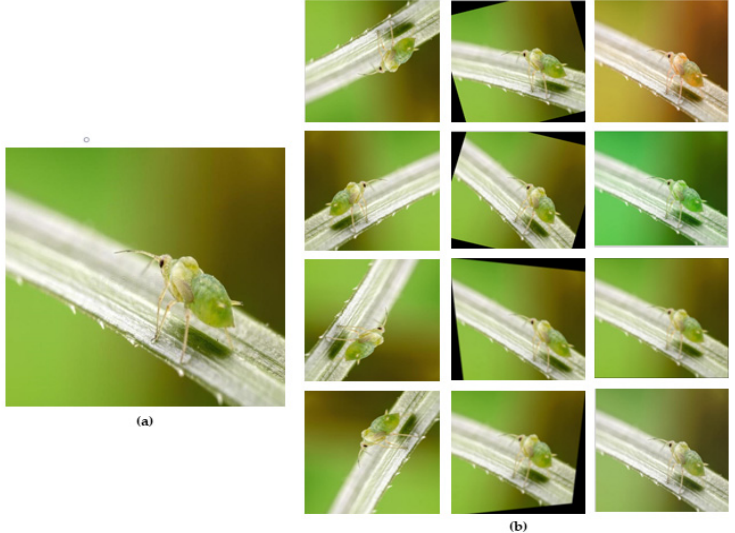
Figure 4. The augmentation is carried out by applying shifts in horizontal and vertical directions, rotation, horizontal flipping, hue, blur, and saturation. ( a ) Original image. ( b ) Augmented images.